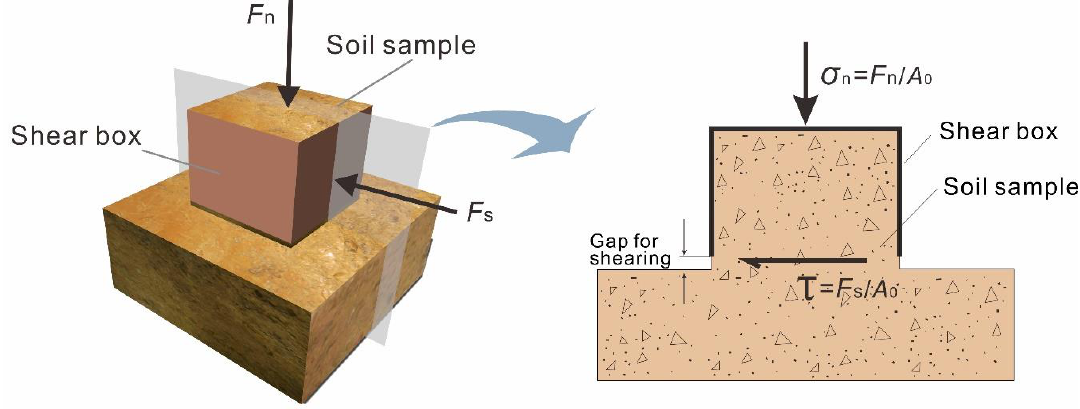
Figure 2. Diagram showing the in situ shear test.